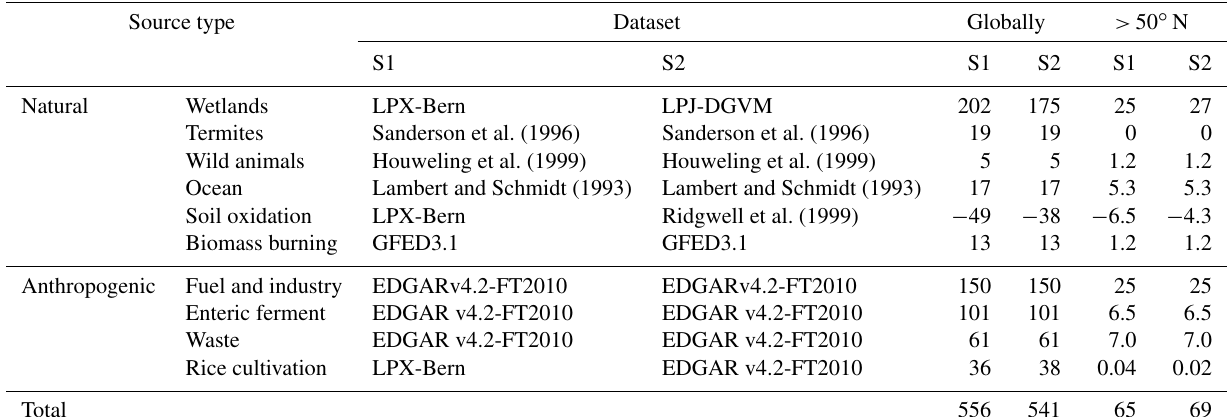
Table 2. Prior fluxes (units Tgyr − 1 ) by source type for 2009. For the wetland fluxes, two different models were used to form sets of prior fluxes for scenarios S1 and